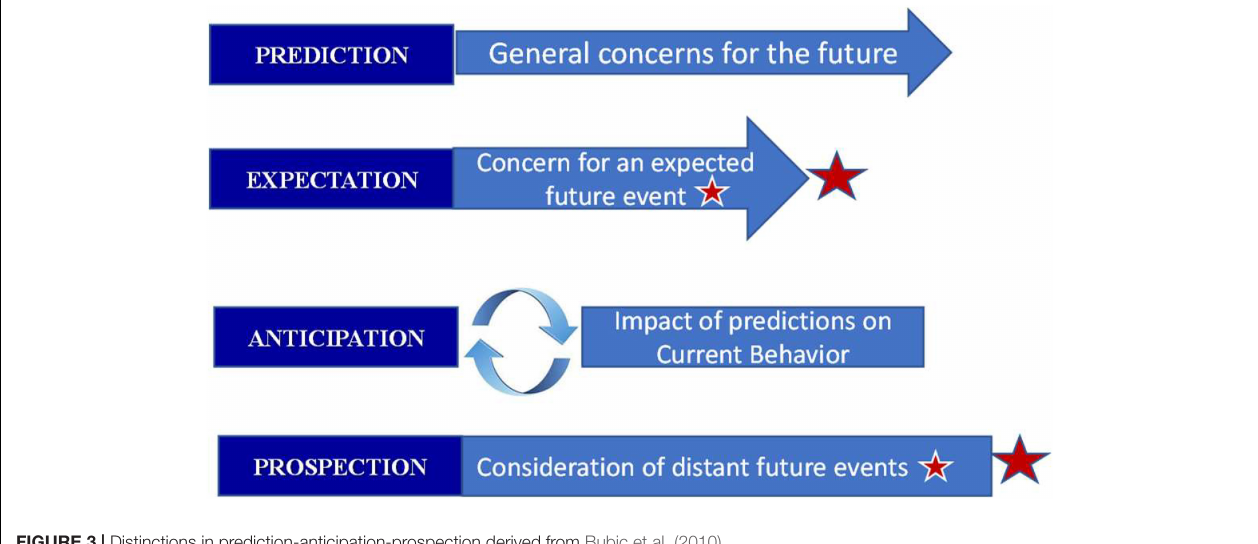
FIGURE 3 | Distinctions in prediction-anticipation-prospection derived from Bubic et al. (2010).